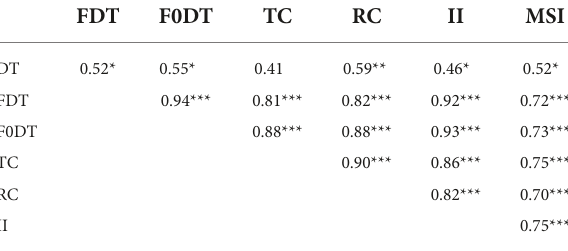
For clarity, only the correlation magnitudes are displayed, but all comparisons were congruent in that better performance on one measure corresponded with better performance on another. Correlation coefficients and p -values associated with p -values less than 0.05 are emboldened. DT, detection thresholds; FDT,